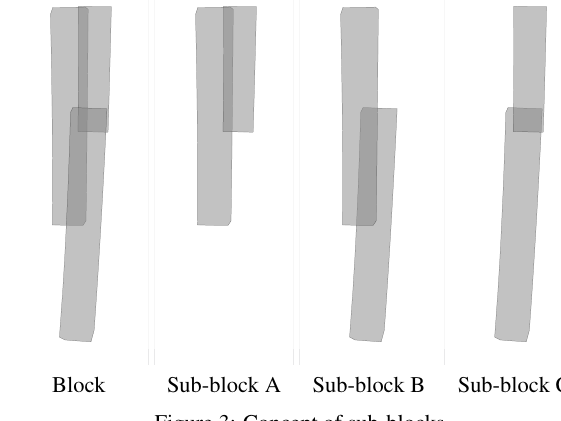
Figure 3: Concept of